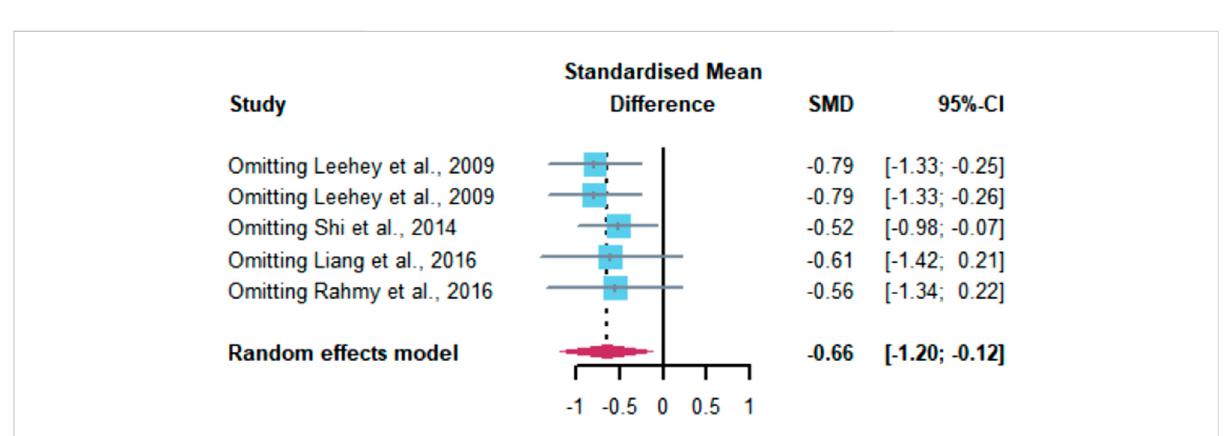
Meta-analysis of aerobic exercise affecting